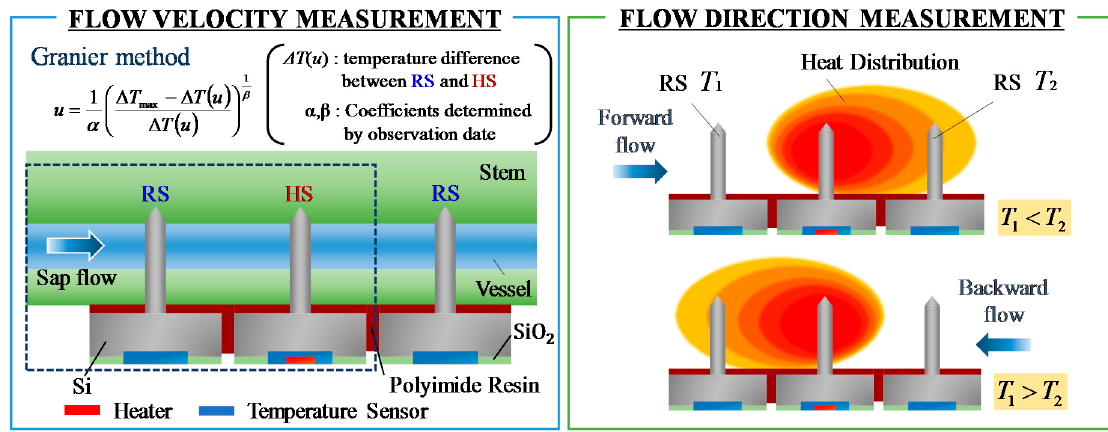
Figure 2. Measurement principle of the proposed sensor.